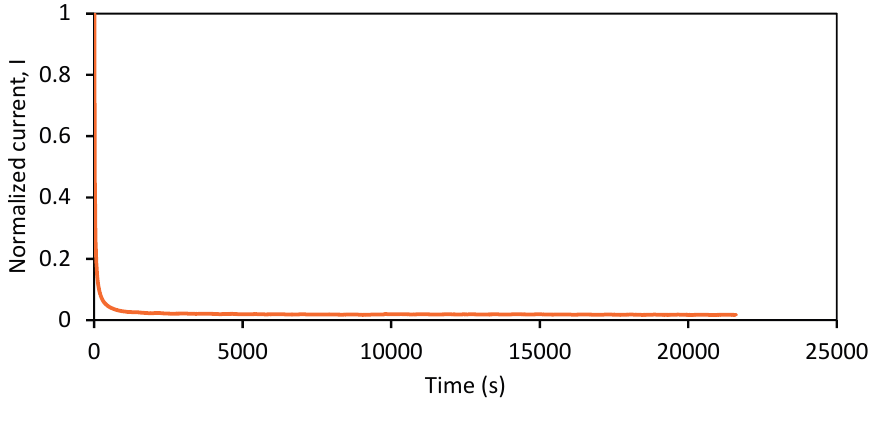
Figure 7. Normalized current versus time for polymer electrolyte films with the addition of 20 wt%